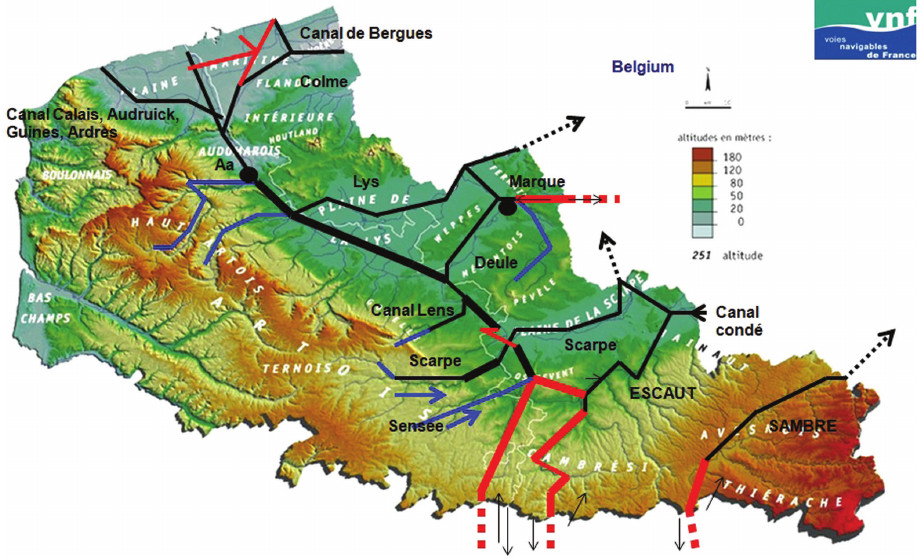
Figure 4. Inland Navigation Network in the North of